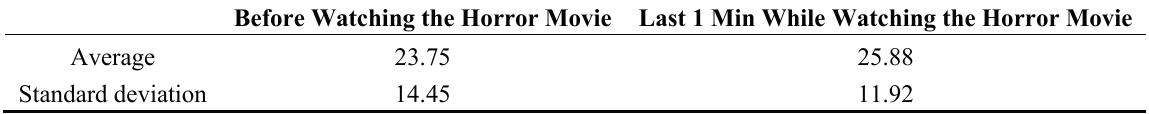
Figure 15. Comparisons of eye blinking rate before watching the horror movie and in the last 1 min of watching the movie (BR is blinking rate). Table 6. Average values and standard deviations of the eye blinking